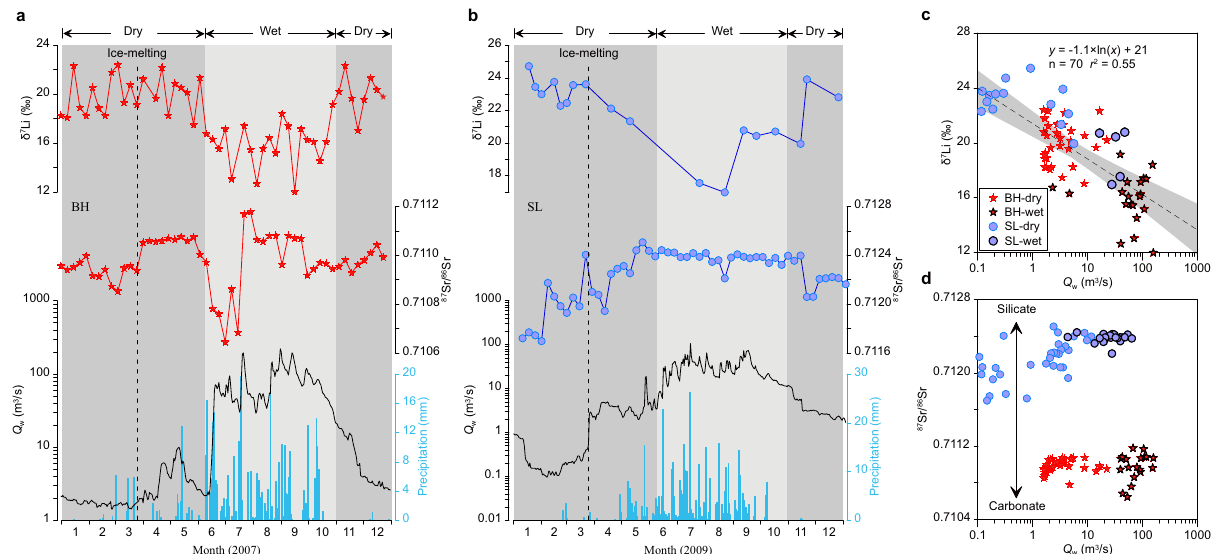
Fig. 1 High-resolution river water δ 7 Li, 87 Sr/ 86 Sr, and hydrometeorological data from the NE Tibetan Plateau. Weekly variations of δ 7 Li and 87 Sr/ 86 Sr in the carbonate-dominated BH ( a ) and silicate-dominated SL ( b ) catchments (Supplementary Fig. 2) along with daily Q w and precipitation, showing inverse trends between δ 7 Li and Q w in each river. When plotting up weekly data from the two rivers together ( c ), there is still an overall negative relationship, highlighting a strong hydrology control on riverine δ 7 Li. ( d ) 87 Sr/ 86 Sr versus Q w , showing large differences between the two rivers, re fl ecting their distinct lithology (Supplementary Fig. 3). The dashed lines in a and b represent ice-melting times. Errors for δ 7 Li are <0.9 ‰ . The shaded regions in c show 95% con fi dence intervals. Symbols with black borders in c and d represent wet seasons, and others are dry